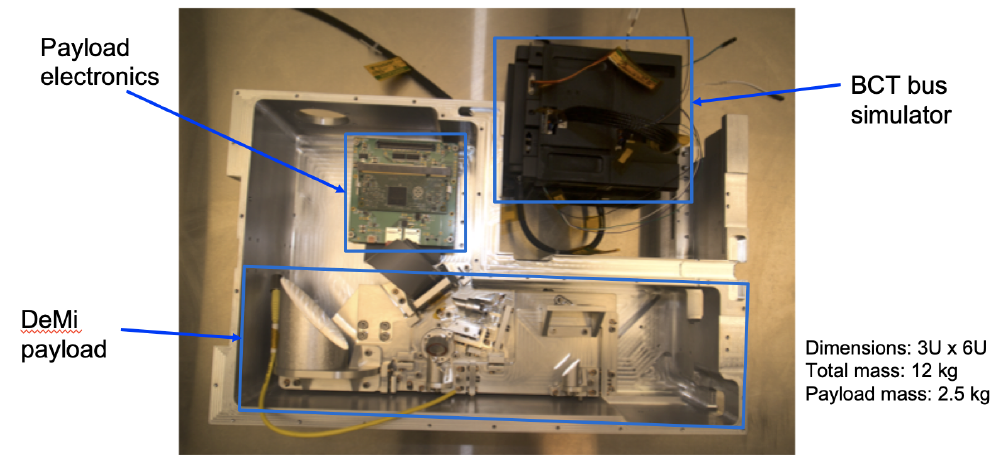
Figure 6. DeMi optical bench and electronics fit check in 6U bus chassis from Blue Canyon Technologies. Entrance baffle (top left), camera controller boards (bottom right) and flight bus stack are omitted.